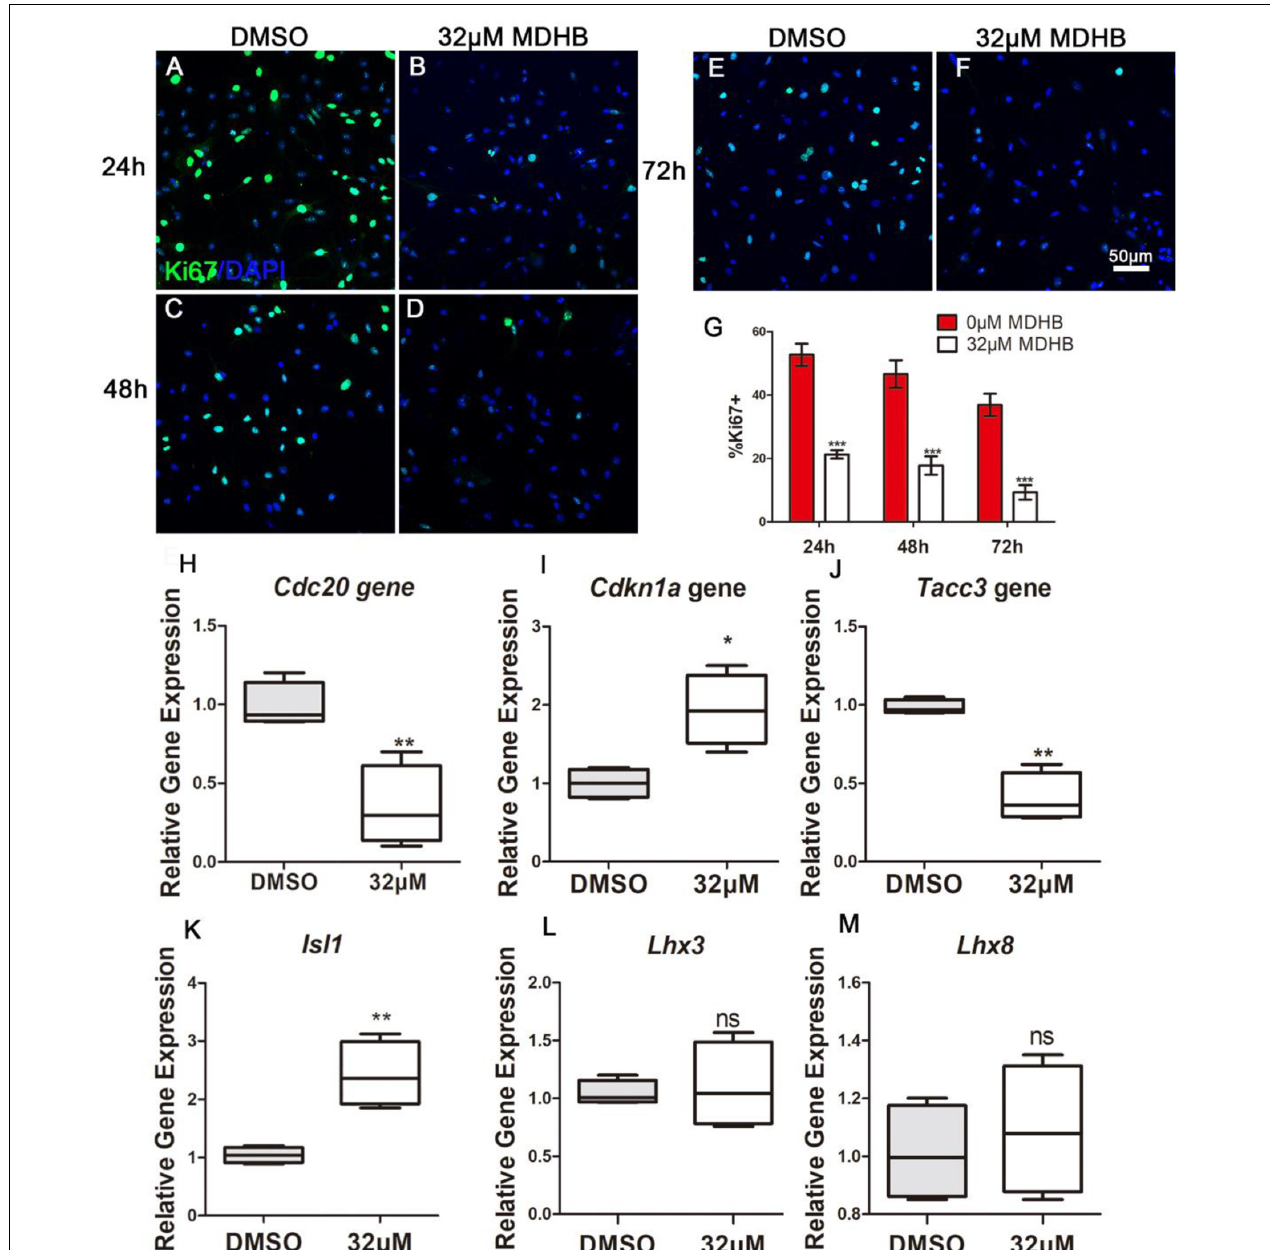
FIGURE 7 | MDHB promotes the differentiation of NSCs into cholinergic neurons by inhibiting cell cycle and increasing cholinergic pathway gene Isl1 . (A) The effect of DMSO on differentiation of NSCs for 24 h; (B) the effect of MDHB on differentiation of NSCs for 24 h; (C) the effect of DMSO on differentiation of NSCs for 48 h; (D) The effect of MDHB on differentiation of NSCs for 48 h; (E) the effect of DMSO on differentiation of NSCs for 72 h; (F) The effect of MDHB on differentiation of NSCs for 72 h; (G) the statistical results of Ki67 staining for different time point. (H) The relative expression levels of Tacc3 gene; (I) the relative expression levels of Cdc20 gene; (J) the relative expression levels of Cdkn1a gene; (K) the relative expression levels of Isl1 gene; (L) the relative expression levels of Lhx3 gene; (M) the relative expression levels of Lhx8 gene ( ∗ P < 0.05, compared with DMSO group; ∗∗ P < 0.01, compared with DMSO group; ∗∗∗ P < 0.001 compared with DMSO group, green = ki67, blue =